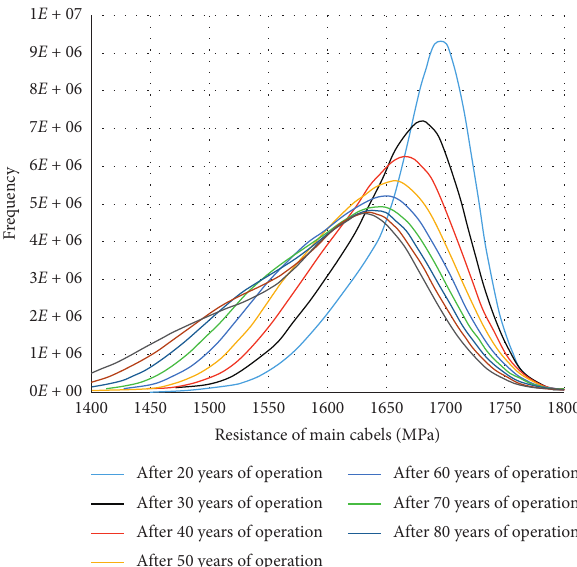
Figure 4: Probability model for the resistance of the main